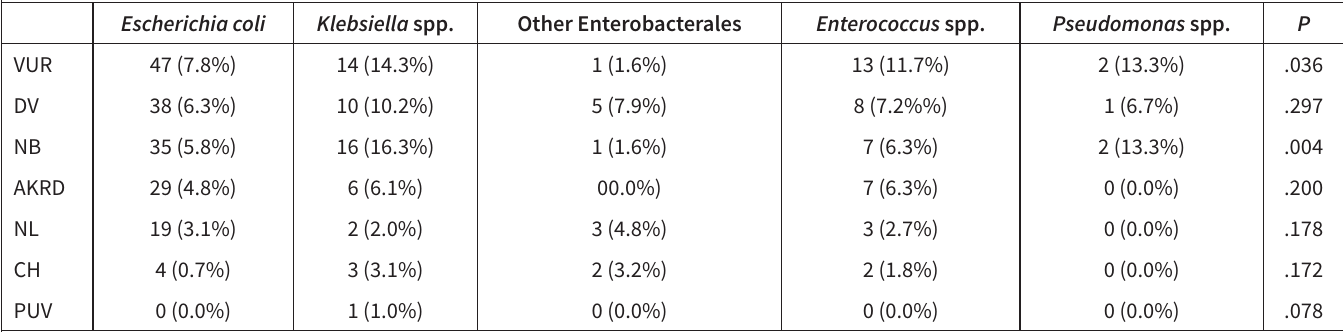
Table 3. The Percentages of Bacteria Isolated from Urine Cultures of Patients with Comorbid diseases Associated with UTI Escherichia coli Klebsiella